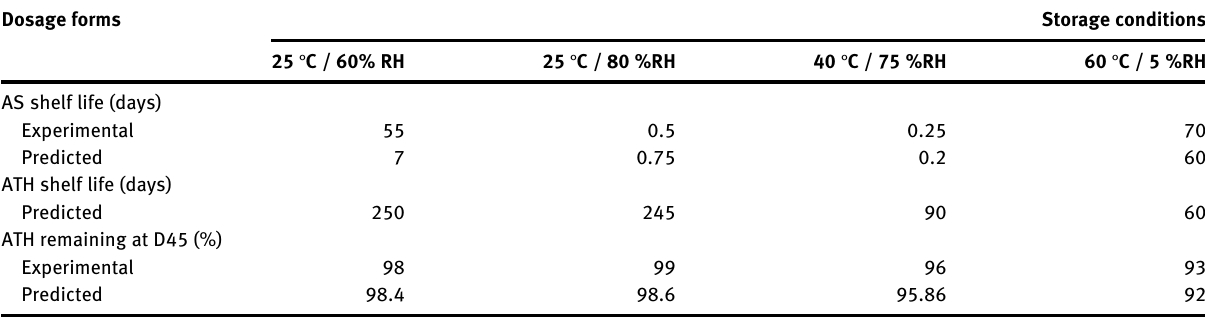
Table  : ExperimentalandpredictedshelflifeofAS(days),experimentalandpredictedpercentageofATHremainingattheendofthestability study,andpredictedATHshelflife(days)at thefourenvironmentalconditionsof thestudy(  ° C/  and  %RH,  ° C/  %RHand  ° C /  %